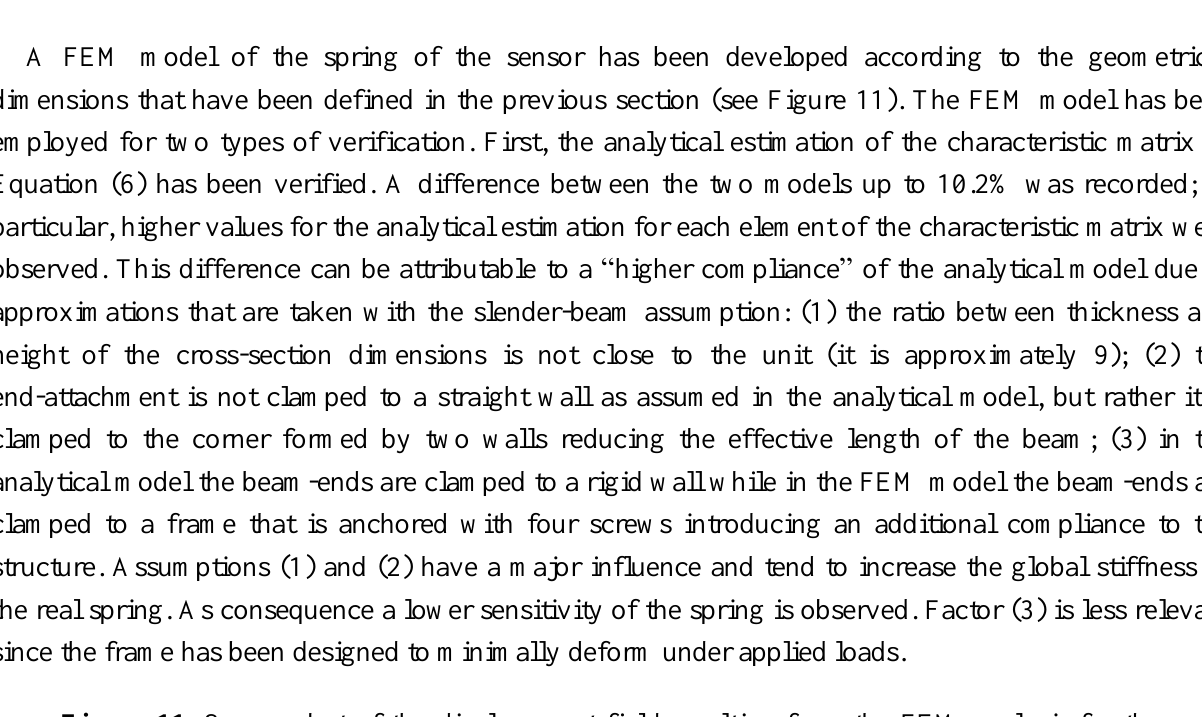
Figure 11. Screen-shot of the displacement field resulting from the FEM analysis for the nominal force in Load Condition A ( left ) and Load Condition B ( right ). Displacements are amplified by a factor of 10 for the purposes of the